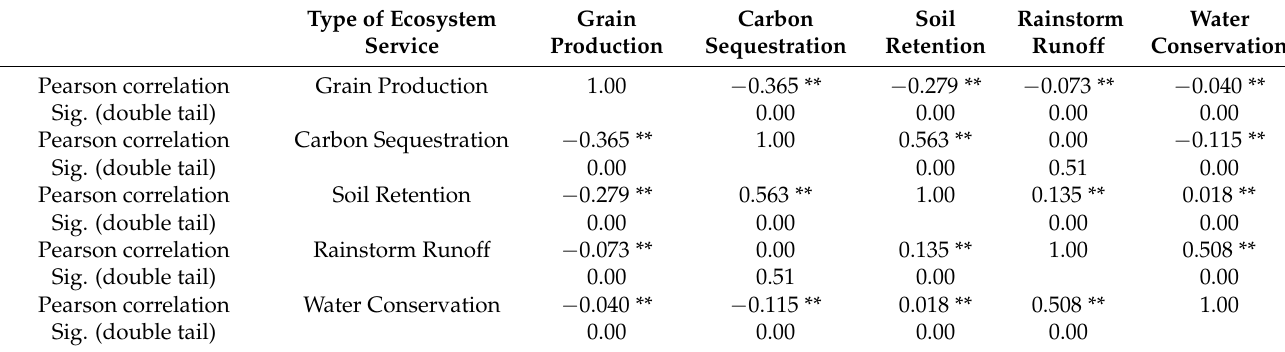
Table 6. Pearson Correlation Coefficient for Ecosystem Service in the Greater Bay Area